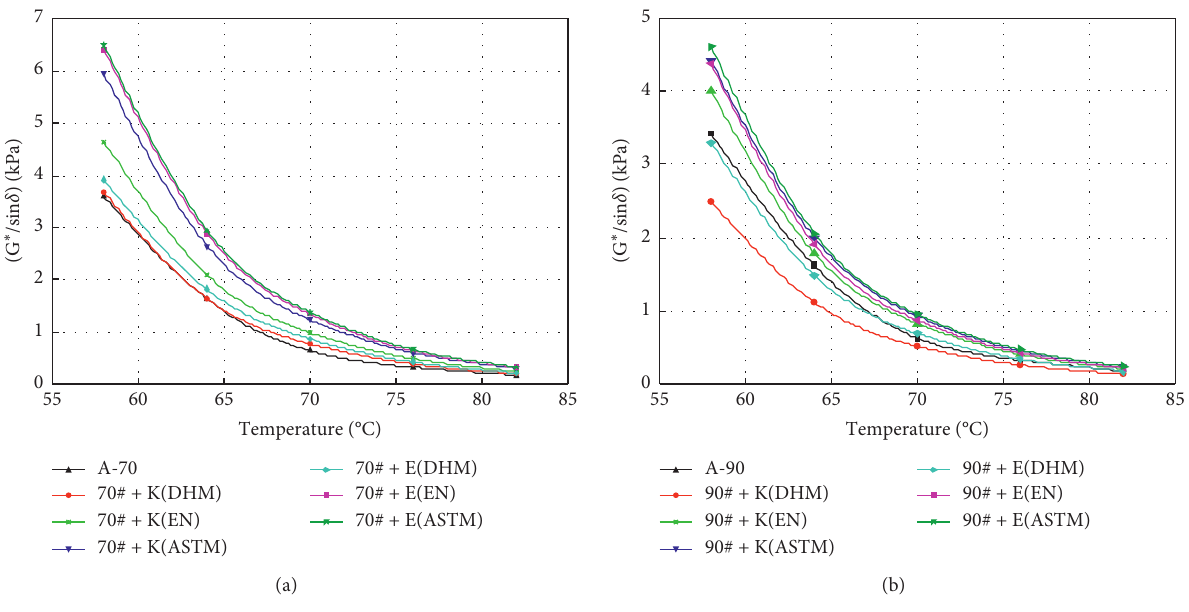
Figure 5: Variation of the rutting factor of the emulsified asphalt residue with